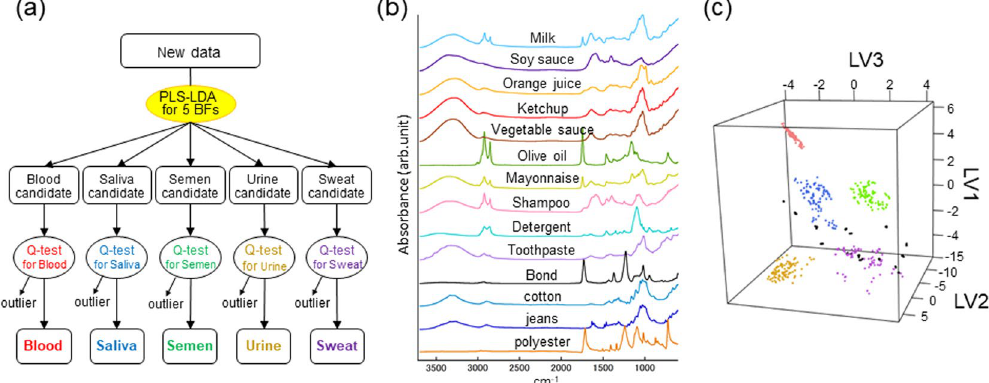
Figure 3. Identification of the ATR FT-IR spectra of non-BF samples as outliers using Q-statistics for each BF group. ( a ) A discrimination scheme using a PLS-LDA model for the five BF types followed by Q-tests for each BF type. ( b ) Average ATR FT-IR spectra of prepared non-BF samples, including milk, soy sauce, ketchup, vegetable sauce, olive oil, mayonnaise, shampoo, laundry detergent, toothpaste, glue, cotton cloth, jeans and polyester cloth. All spectra were normalized by the total area. ( c ) PLS-DA scores for the ATR FT-IR spectra of the non-BF samples, predicted by the five-class PLS-DA model for fresh BFs (black